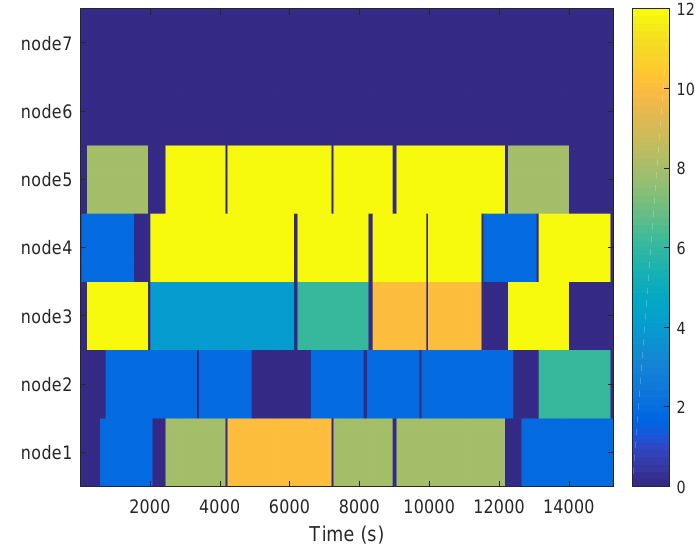
Figure 9. Overall system load for Scenario A using an exclusive node assignment